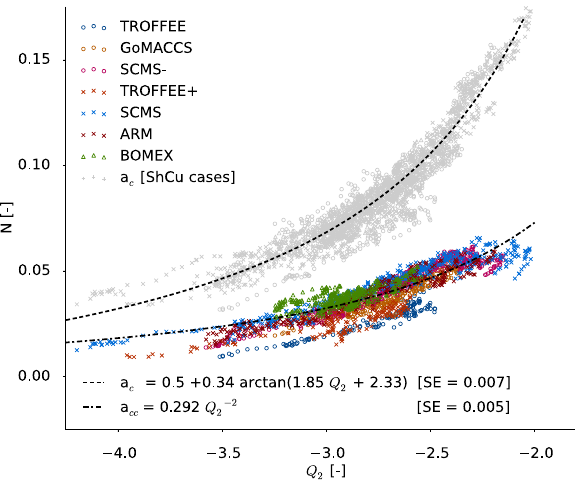
Figure 5. Scaling of the cloud core vertical velocity ( w cc ) as a func- tion of the Deardorff convective velocity scale ( w ∗ ). Circles repre- sent free convection situations, crosses indicate wind situations. The line represents a least square fit, which is forced through 0. d repre- sents the index of